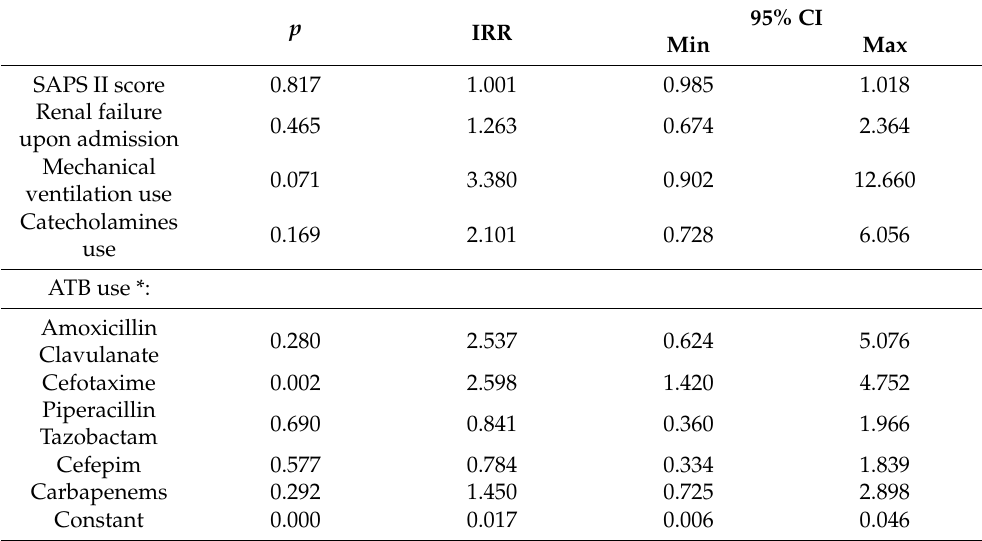
Table 4. Multivariate analysis in the prediction of ESBL-PE